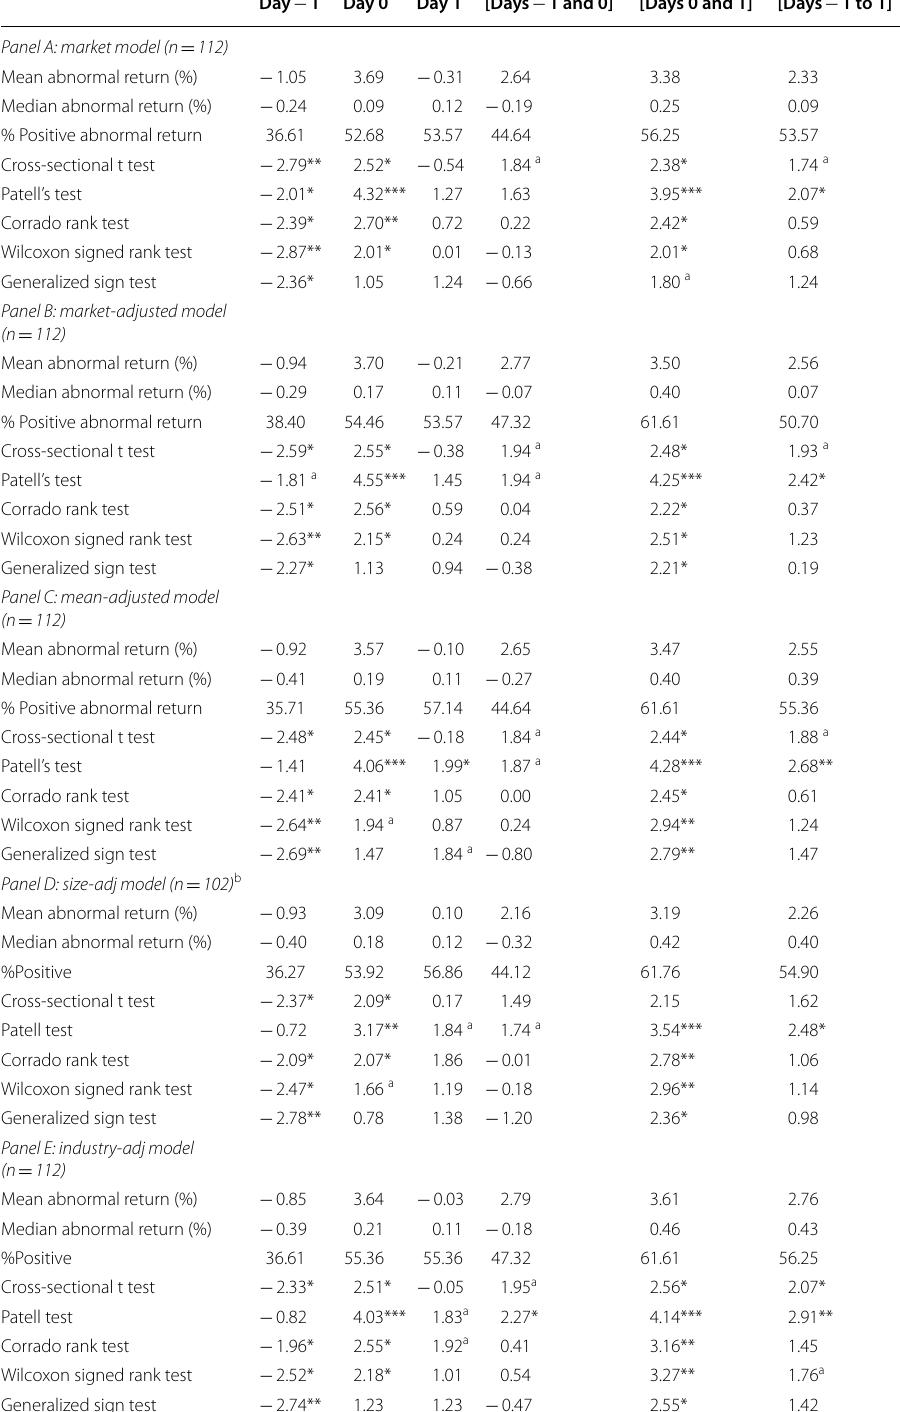
Table 7 Event study results (Trim